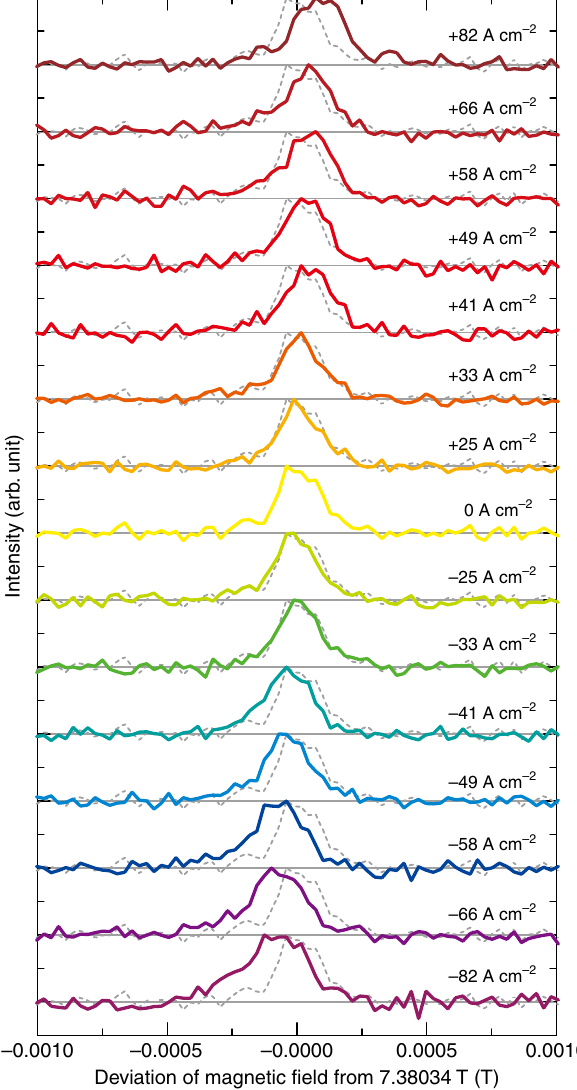
Fig. 3 Line H in 125 Te-NMR spectrum for different electric current densities. The NMR spectra are shown as a function of deviation of magnetic fi eld felt by the 125 Te nuclei (see Methods) from 7.38034T. The values of pulsed electric current densities are 0, ± 25, ± 33, ± 41, ± 49, ± 58, ± 66, and ± 82 A cm − 2 . The spectrum in the absence of a pulsed electric current (dashed lines) is indicated in each row for comparison